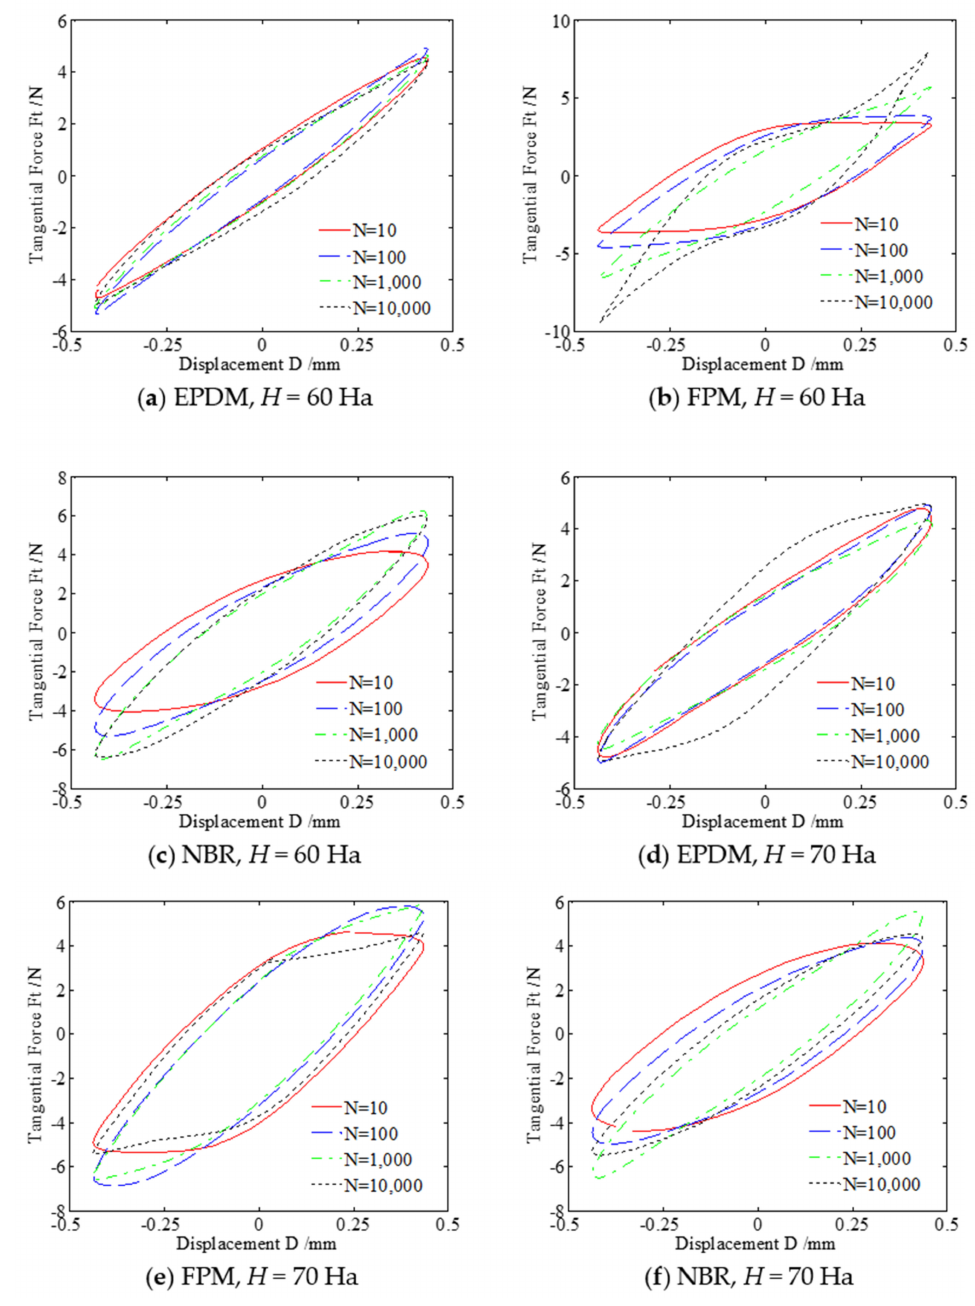
Figure 5. Curves of three rubbers under F n = 5 N, d = ± 0.45 mm, and f = 10